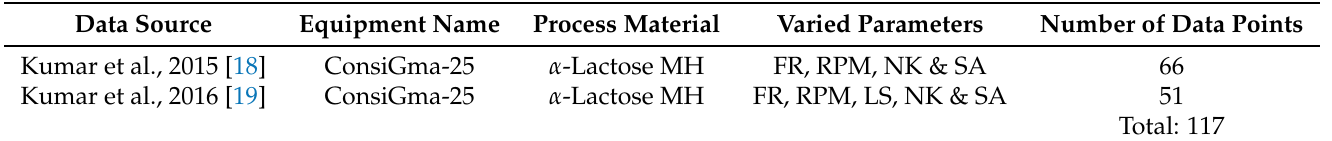
Table 1. Summary of the twin screw granulation RTD and sieve fractions available and collected from